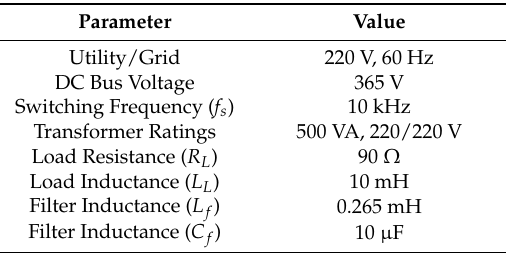
Table 4. System Parameters.